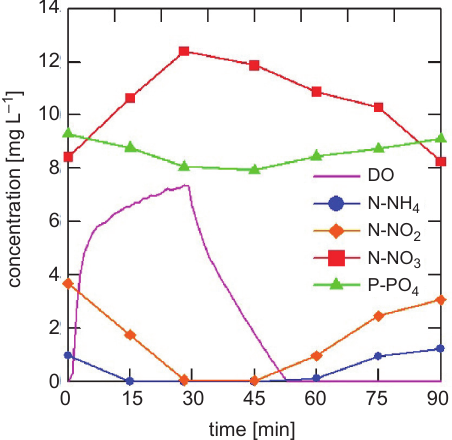
Fig. 4 – Oxygen, ammonium, nitrite, nitrate, and phosphorus concentration profiles in the IACMB. Operating cycle 30–60, t = 30 min, t = 60 aer mix